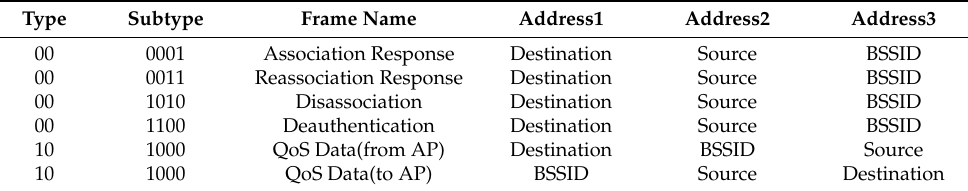
Table 2. Information fields description.